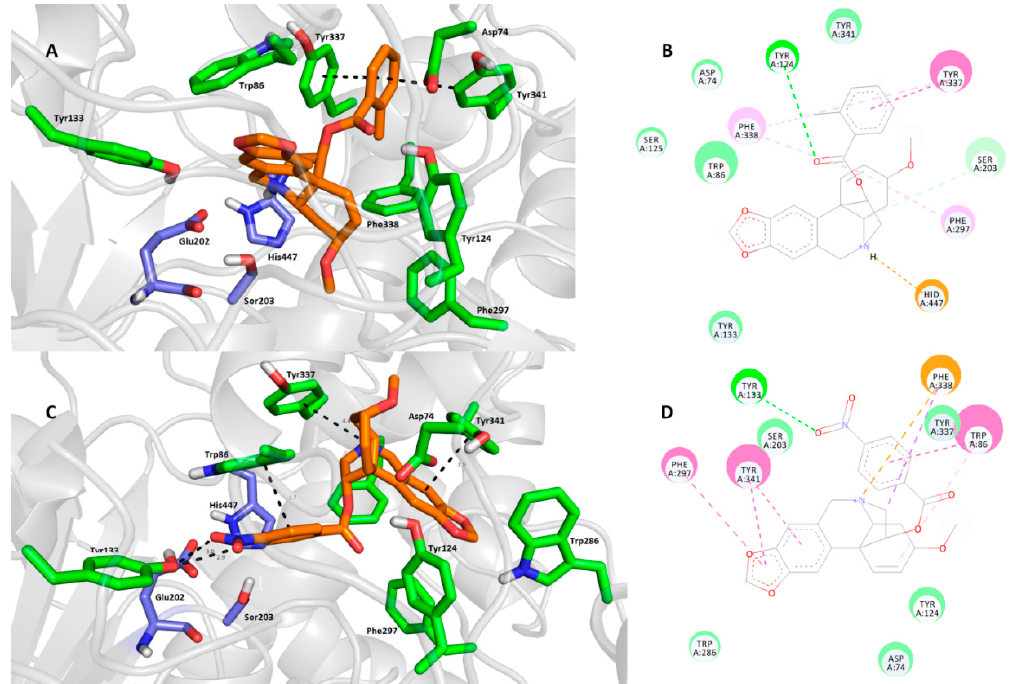
Figure 3. Top-scored docking poses of compounds 1j ( A , B ) and 1m ( C , D ) in the h AChE active site (PDB ID: 4EY7) [44]. Close-up view for each ligand is presented as three-dimensional ( A , C ) and two-dimensional ( B , D ) diagrams, respectively. In A and C — 1m and 1j are presented in orange, important amino acid residues in green and the catalytic triad in dark blue. Dashed lines in all figure parts represent crucial intermolecular interactions of different origin (hydrogen bonds–orange lines, π - π / π -cation stacking–pink/purple lines, van der Waal’s interactions and other hydrophobic forces–green lines). Figures A and C were created with The PyMOL Molecular Graphics System, Version 2.0 Schrödinger, LLC. Figures B and D were rendered with Dassault Systèmes BIOVIA, Discovery Studio Visualizer, v 17.2.0.16349, San Diego: Dassault Systèmes, 2016.